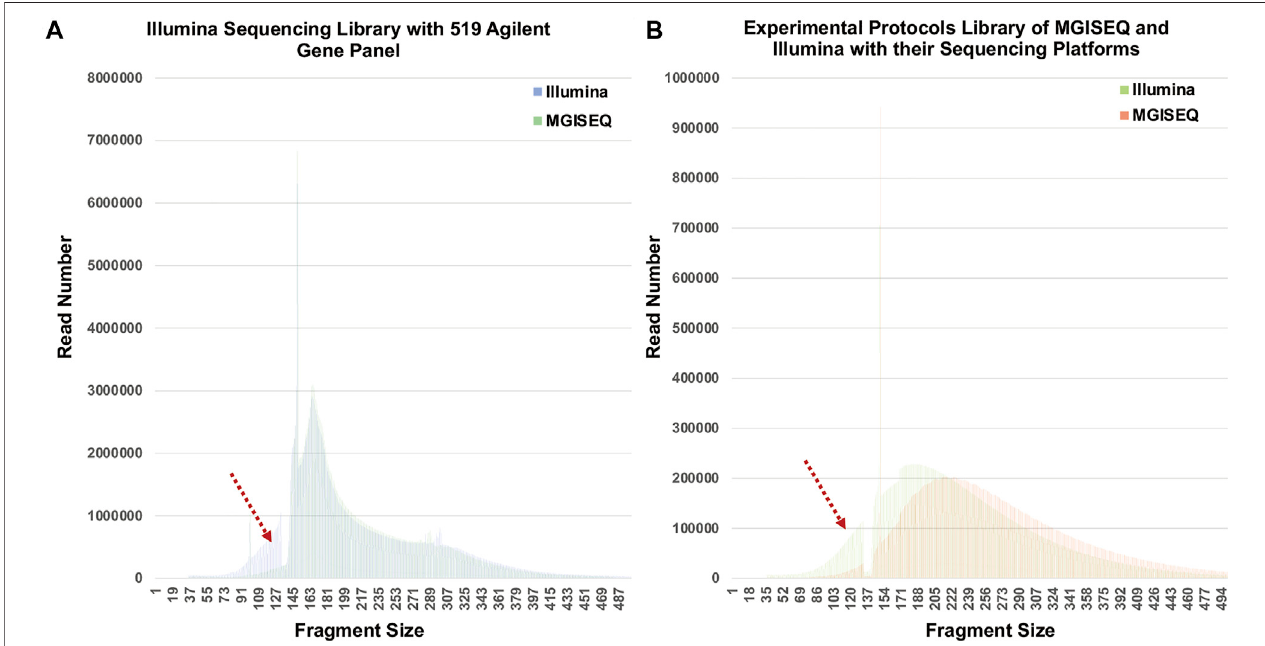
FIGURE5| FragmentDistribution inIlluminaNextseq500 andMGISEQ-2000. (A) Thelibrarieswereconstructed followingtheinstructions ofIlluminaandcaptured with an Agilent 519 gene panel. ( B) Fragment distribution when experiments were performed according to the experimental systems and kits recommended by Illumina and MGISEQ,